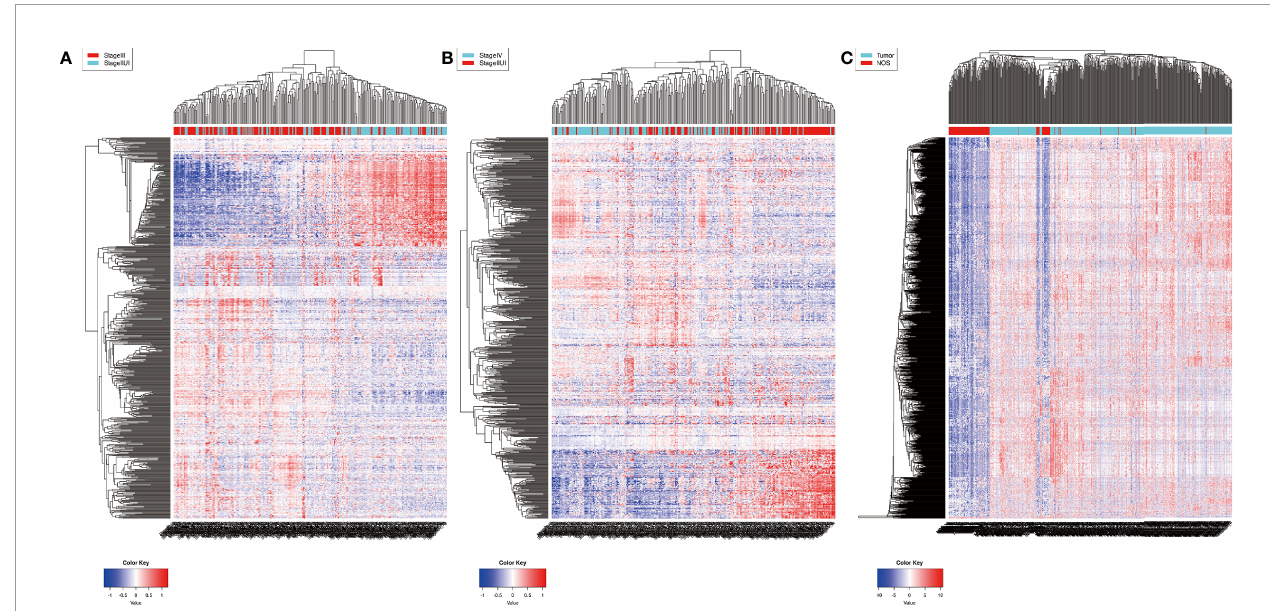
FIGURE 1 | Identi fi cation of differentially expressed RNAs in bladder cancer. heatmap (A, B) 2076 mRNAs and 381 lncRNAs were differentially expressed between ACS-BCa and LCA-BCa samples (429 and 501 upregulated mRNAs, 59 and 38 upregulated lncRNAs, and, 138 and 101 downregulated mRNAs, 17 and 23 down- regulated lncRNAs) (P < 0.05, |fold change (FC)| > 2.0); heatmap (C) 1696 miRNAs were differentially expressed in BCa compared to non-cancerous tissue samples (1593 up-regulated and 103 down-regulated) (P < 0.01, |FC| >